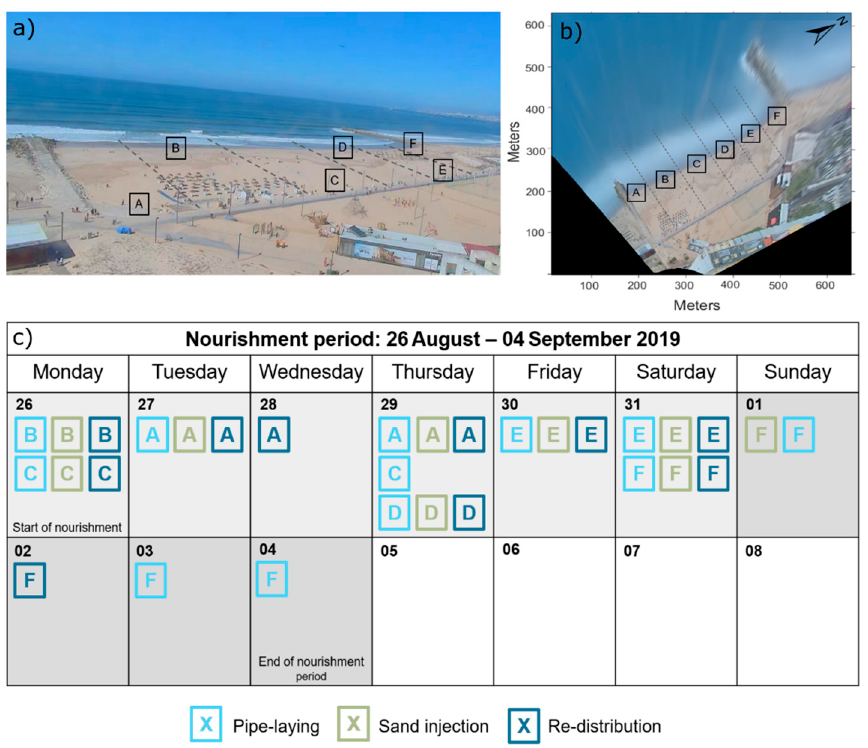
Figure 6. The beach nourishment works calendar for the nourishment period. ( a ) Nourishment zones; ( b ) nourishment zones displayed on rectified image; ( c ) the nourishment calendar, indicating the zones where each phase took place, on each day.